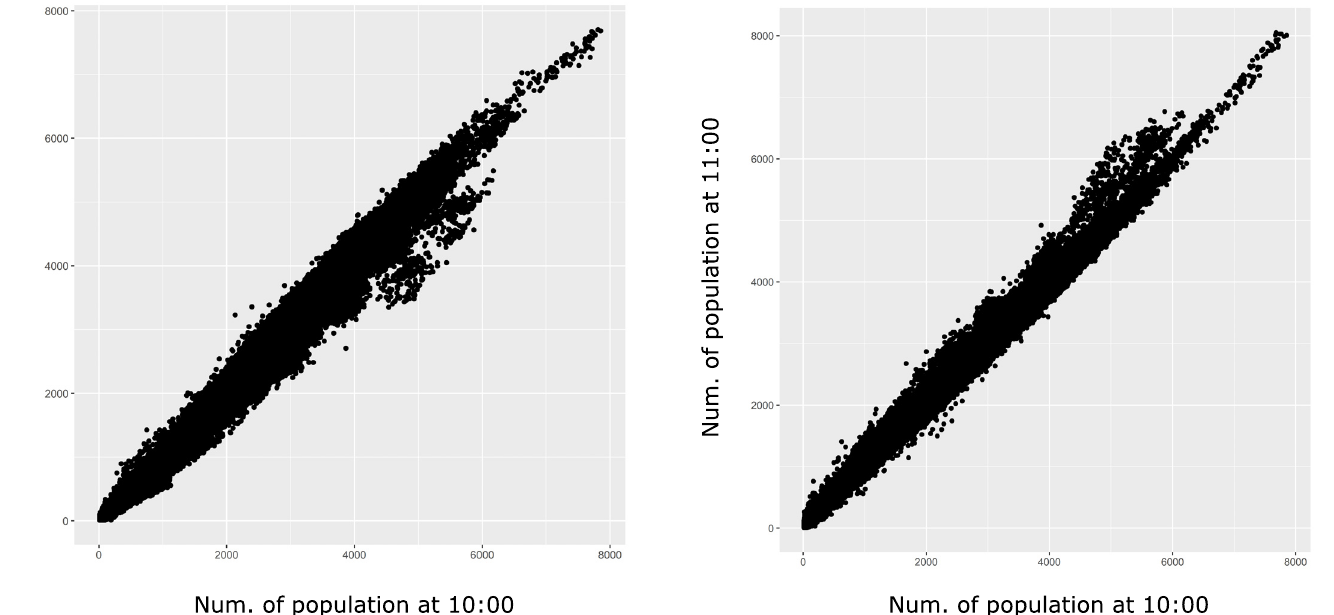
Fig 3. Comparison of temporary population at 10:00 a.m. to 9:00 and 11:00 a.m. The data includes the average population on Thursdays in November 2019 in Tokyo MA.